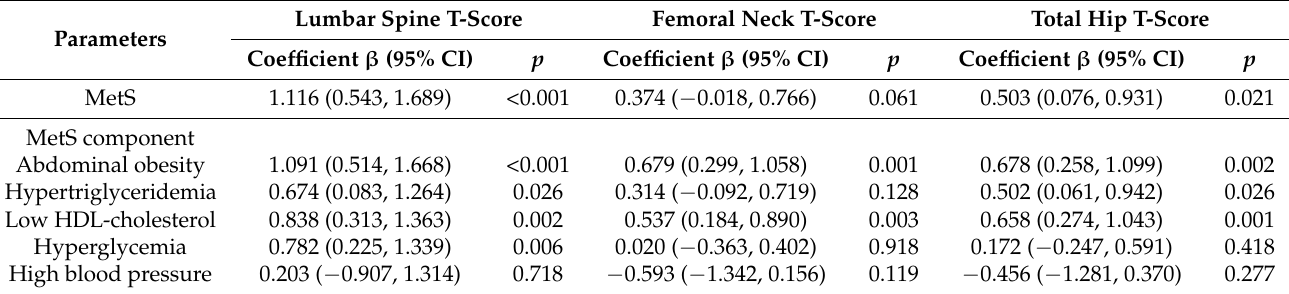
Table 2. Association between MetS and its components and BMD T-score using multivariable linear regression analysis in all study patients ( n =